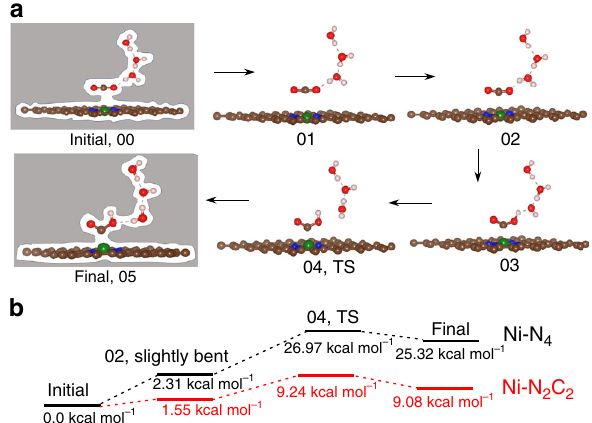
Fig. 3 Reaction pathways and barriers for CO 2 to cis-COOH conversion. a The minimum energy path calculation using the CI-NEB method with implicit solvation. We consider total six images (00 – 05) for this process. The initial linear CO 2 interacts with neighboring water molecule to form a slightly bent structure (image 02). Later this bent CO 2 takes a proton from water to produce cis-COOH product (05 image) via the transition state (TS) at image 04. The arrow shows the forward reaction. b Reaction energies and TS barrier for the protonation step for CO 2 reduction on the Ni – N 4 and Ni – N 2 C 2 sites at − 0.8 V vs RHE applied potential. The proton transfer occurs most easily on Ni – N 2 C 2 , followed by Ni – N 3 C 1 and Ni – N 4 site. Note that in these calculations the charge of the system changes continuously as the H moves from water to OCO to form OCOH* and OH − . There is not a separate electron transfer step as in the proton coupled electron transfer (PCET) surface hopping picture. (Gray color: entire surface represents implicit solvation along the whole reaction pathways, brown: carbon, blue: nitrogen, green: nickel, red: oxygen, off white: hydrogen